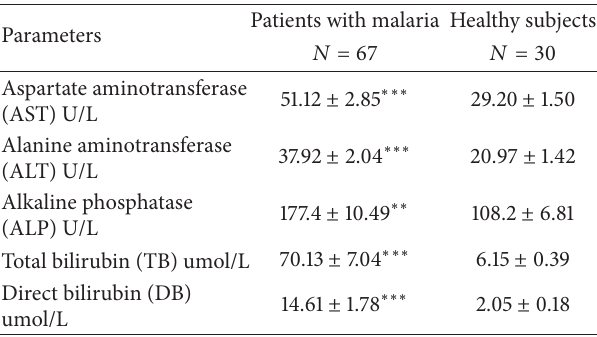
Table 4: Changes in liver functions biomarkers of the patient’s P. falciparum malaria and healthy